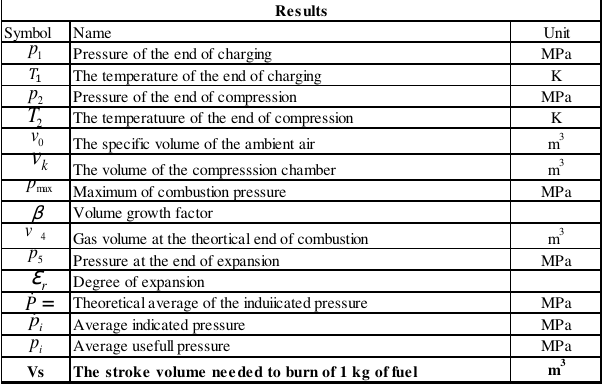
Table 3. The results of subsequent actions on constants and variables